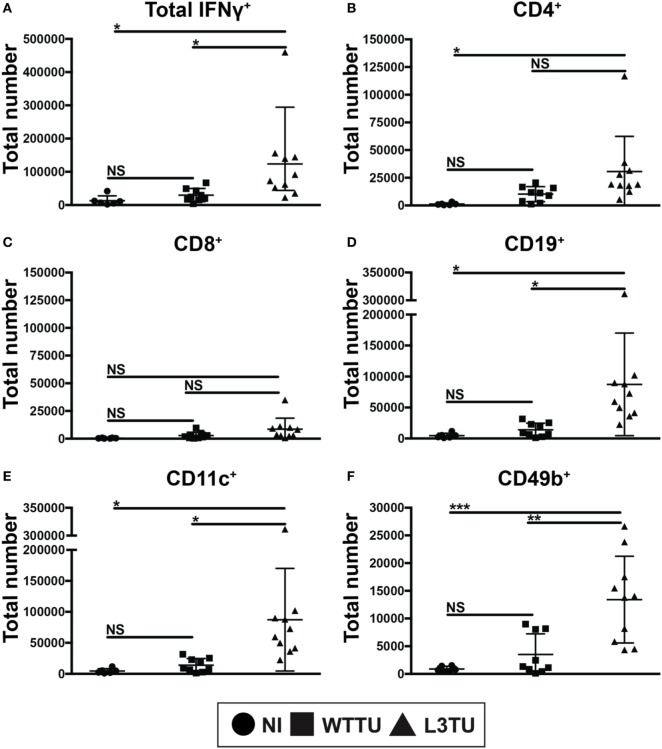
aCCL3 enhances the accumulation of IFNg+ cells in the TDLN. Absolute numbers of (A) IFNg+ total immune cells, or IFNg+ immune cells expressing (B) CD4, (C) CD8, (D) CD19, (E) CD11c, and (F) CD49b in the TDLN on day 5 following tumor inoculations were measured by FACS. N = 4–10 mice per group with two repeats. Not significant, ns; p > 0.05, *p = 0.01–0.05, **p = 0.001–0.01, ***p = 0.0001–0.001, ****p < 0.0001.